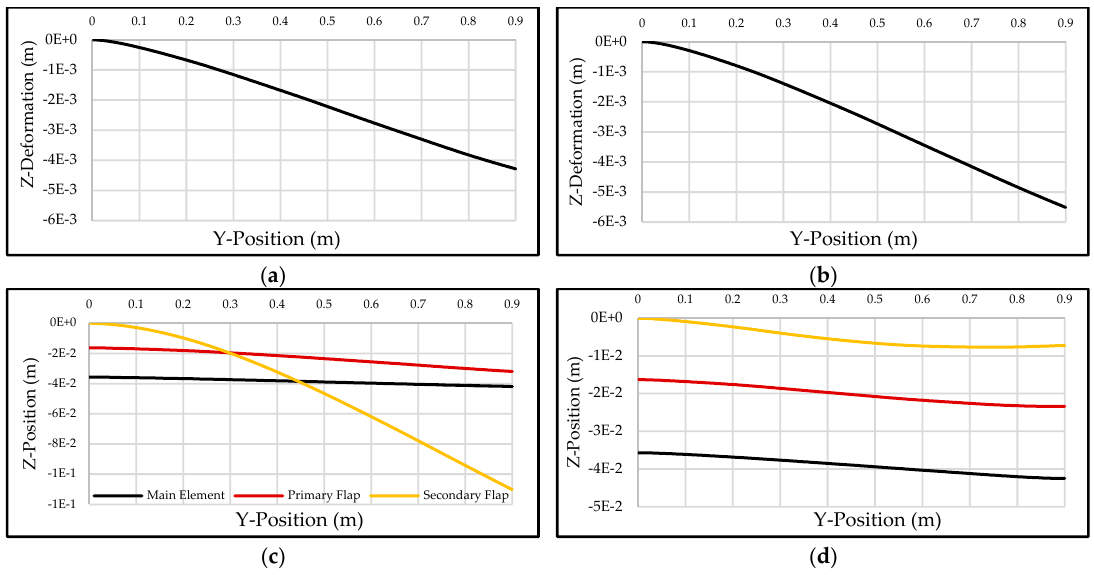
endplates; ( b ) one-element with endplates; ( c ) three-element without endplates; ( d ) three-element with endplates.